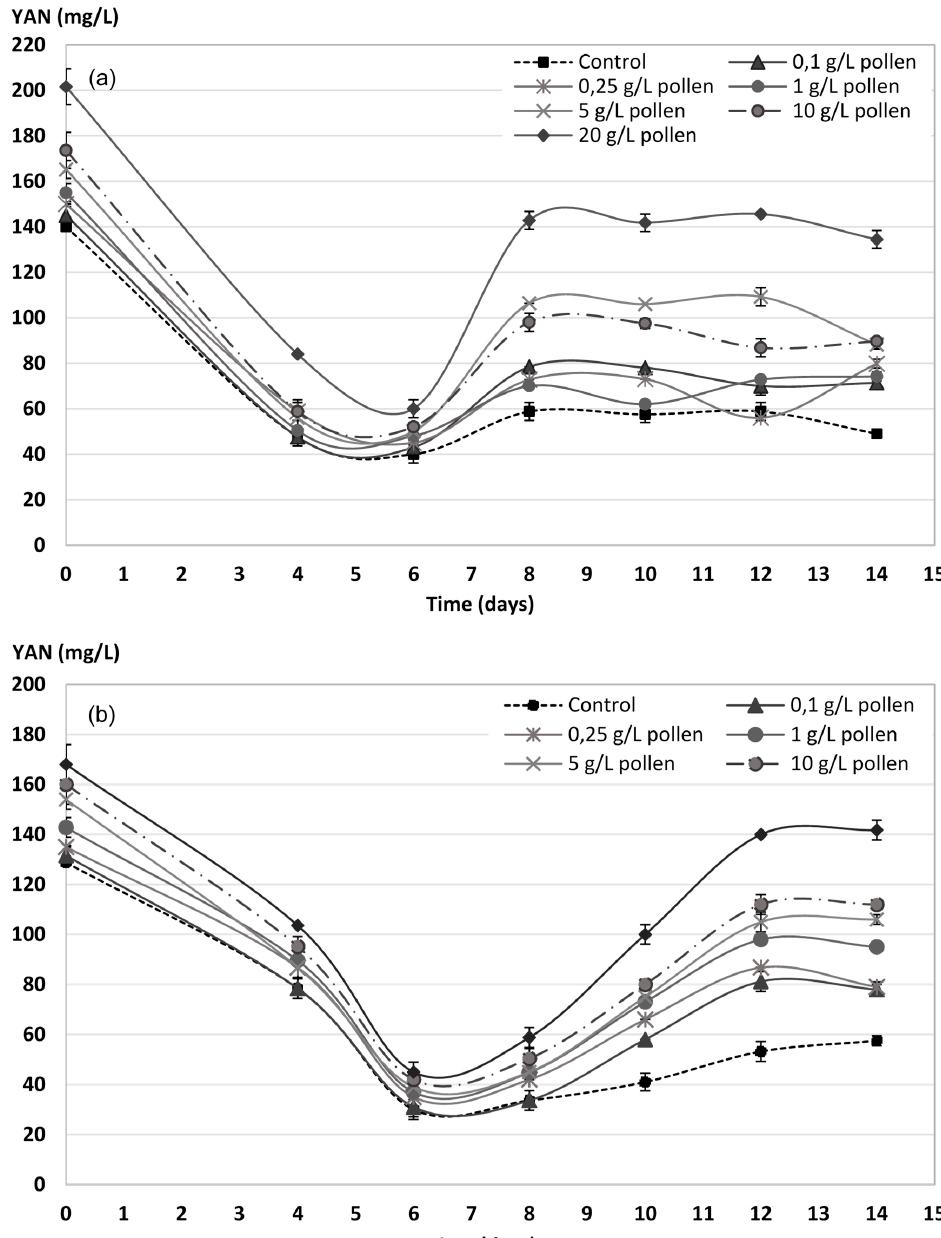
Figure 5. Evolution of the yeast-assimilable nitrogen (YAN) by Saccharomyces cerevisiae yeasts during the AF process of Palomino fino ( a ) and Riesling ( b ) grape musts with bee pollen doses. The results are the mean ± SD of three